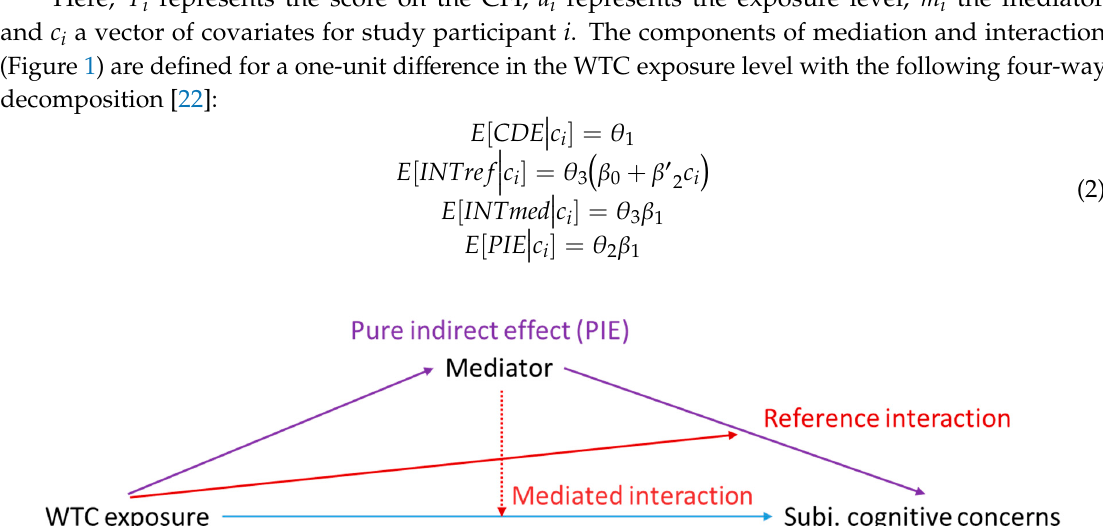
Figure 1. Four-way Decomposition of the Total Effect of World Trade Center Exposure on Subjective Cognitive Concerns. The solid blue line represents the controlled direct effect, or the effect of World Trade Center (WTC) exposure on Cognitive Function Instrument (CFI) score when the mediator is absent. The solid purple lines represent the pure indirect effect, or the component of the total effect of WTC exposure on CFI score that is a result of mediation (and not interaction). The solid red line represents the reference interaction, which is the component of the total effect resulting from interaction and not mediation, and the dotted red line represents the mediated interaction, which is the component resulting from both mediation and interaction.